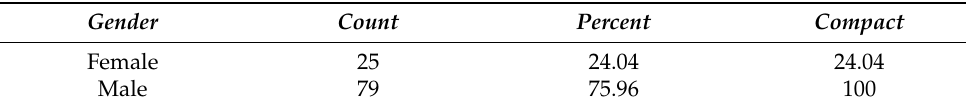
Table 2. Gender of respondents.